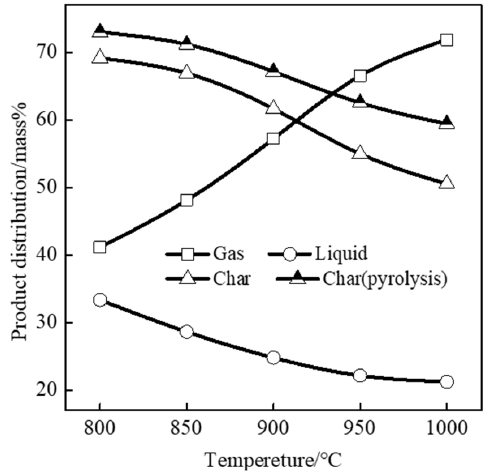
Figure 3. The effect of temperature on the product yield.